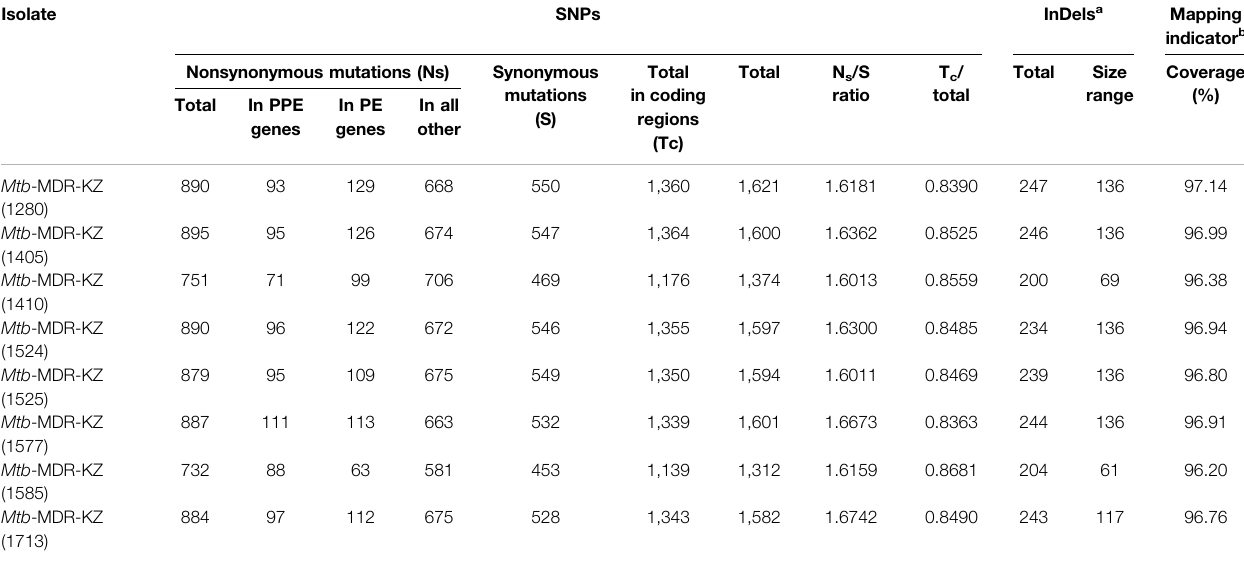
TABLE 3 | Characteristics of genetic variants of MDR-TB isolates: data derived from WGS including mapping indicators.